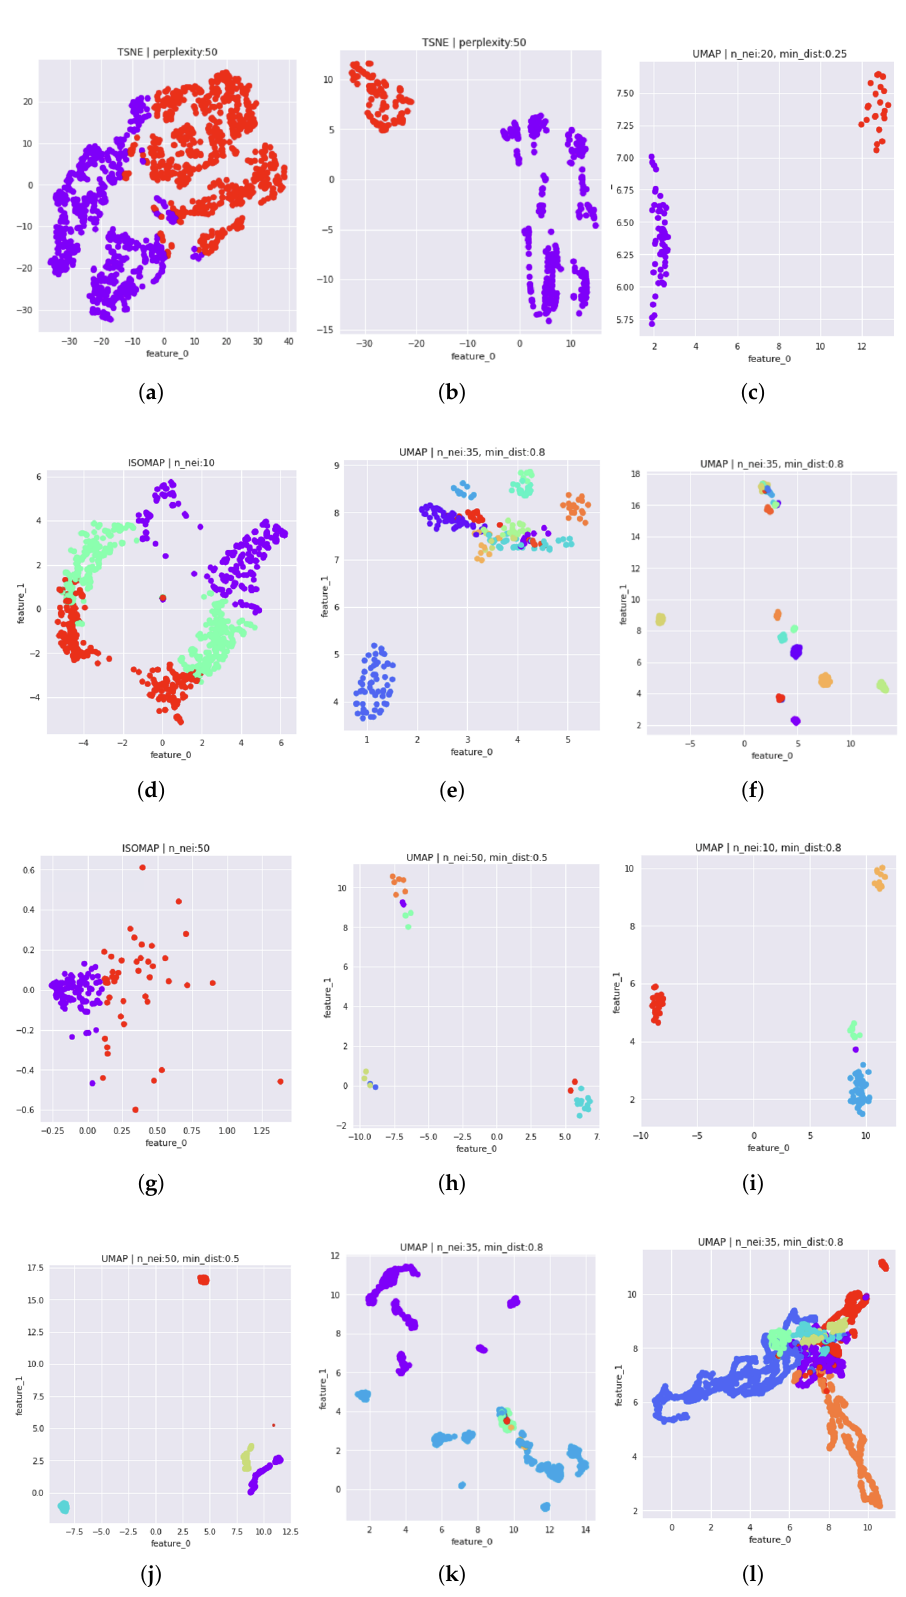
Figure 11. Clustering representation of the information from each device. ( a ) Mobile Network. ( b ) Ra- dio Frequency. ( c ) Bluetooth. ( d ) WiFi. ( e ) Firewall Logs. ( f ) SIEM logs. ( g ) UEBA/Activity Track. ( h ) UEBA/Browsers. ( i ) UEBA/Files. ( j ) UEBA/Network. ( k ) UEBA/Process. ( l )